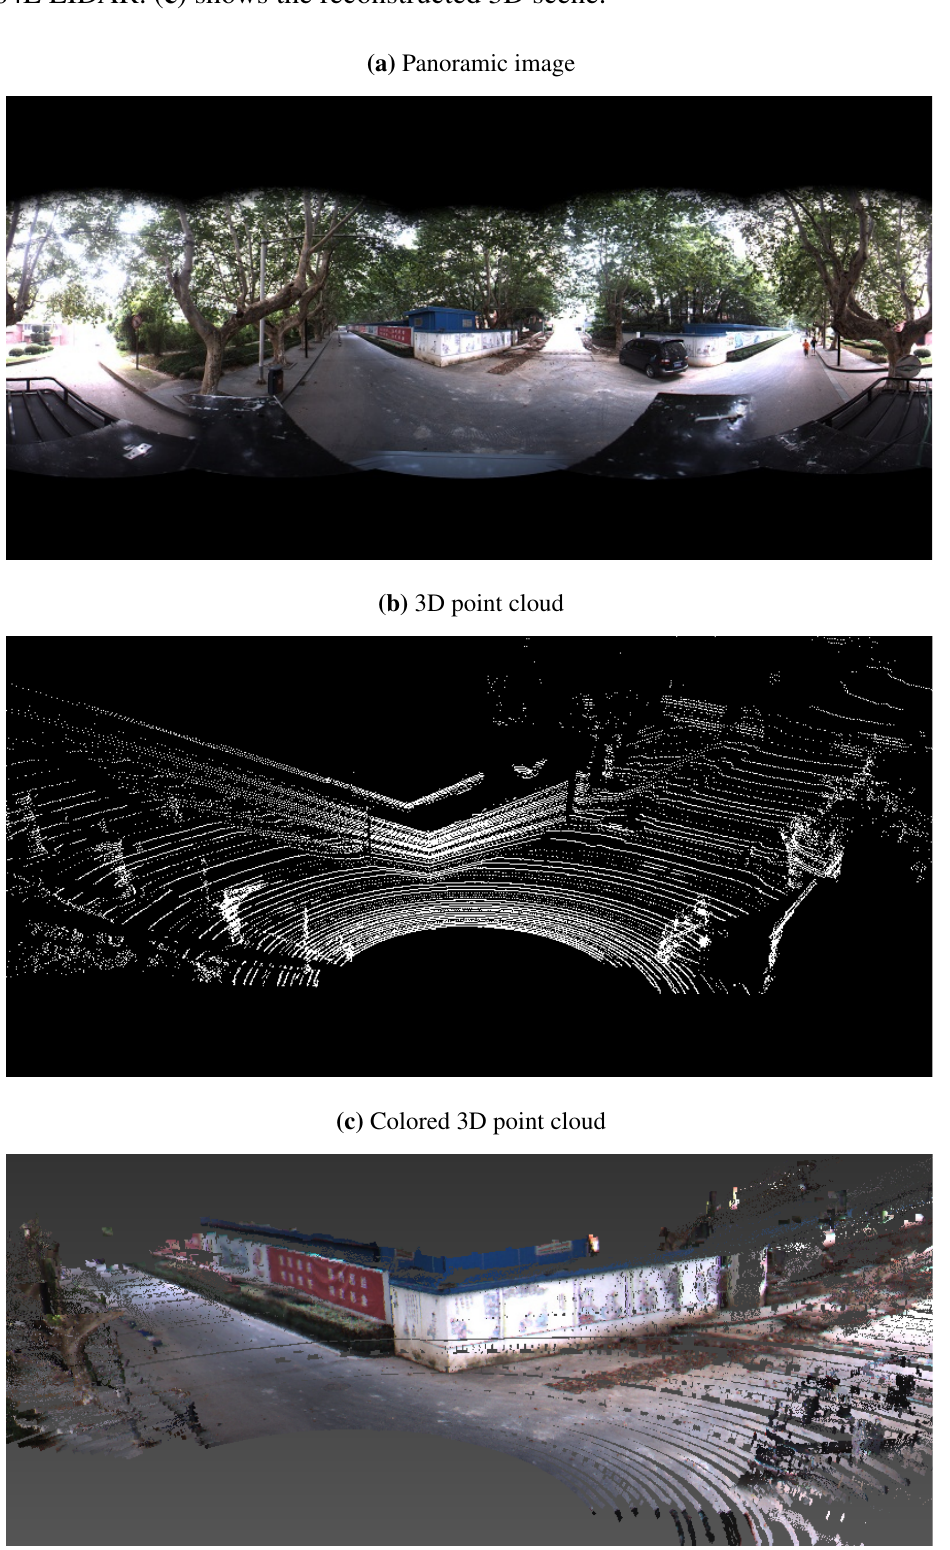
Figure 7. The second LIDAR-camera view used for calibration. ( a ) is the panoramic image captured by a Ladybug3 camera, and ( b ) is the 3D point cloud collected by a Velodyne HDL-64E LIDAR. ( c ) shows the reconstructed 3D